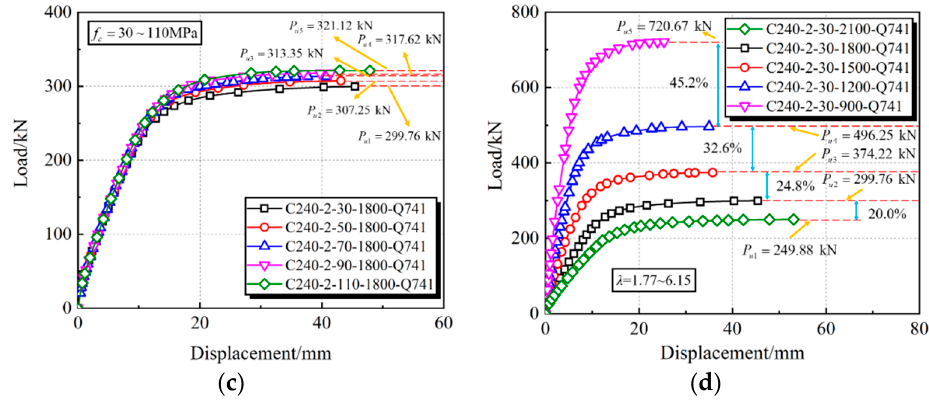
Figure 15. Influence on full ‐ range load–displacement curves. ( a ) Yield strength of steel tube; ( b ) D / t ratio; ( c ) Compressive strength of core concrete; ( d ) Shear ‐ span ratio.